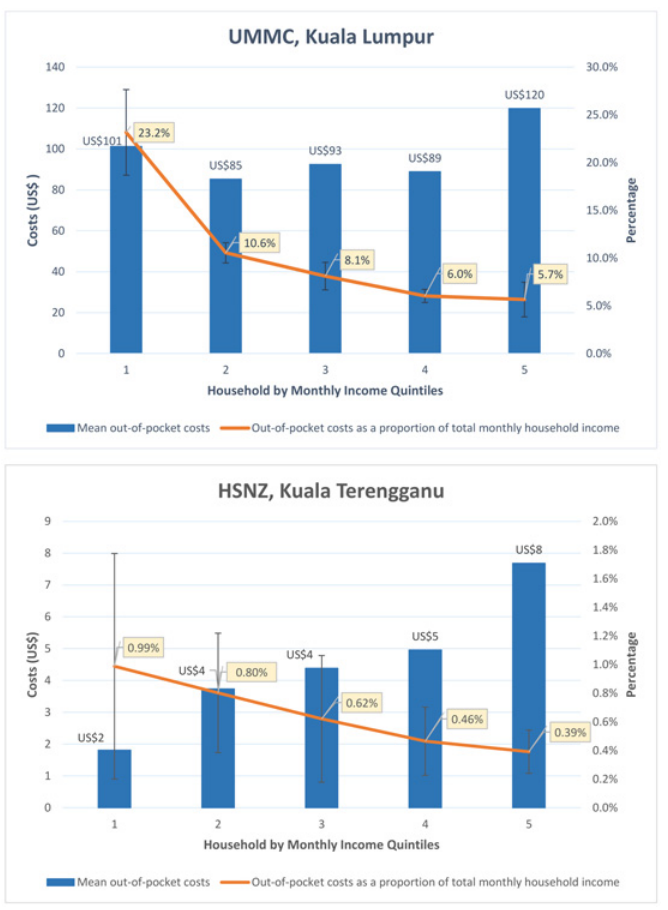
Fig 1. Mean out-of-pocket costs for acute gastroenteritis requiring hospitalization by income quintiles. NOTE: Error bars represent 95% confidence interval of out-of-pocket costs as a proportion of household income; Costs are in 2013 United States Dollars (US$); UMMC, University of Malaya Medical Centre; HSNZ, Hospital Sultanah Nur Zahirah.